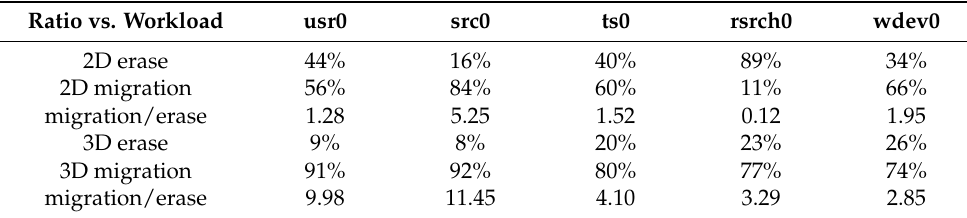
Table 3. Distribution of GC latency on page migration and block erase. Ratio vs.